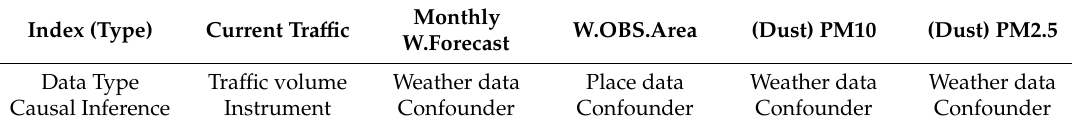
Table 4. Data type and causal inference in database of “Wise way to work”.